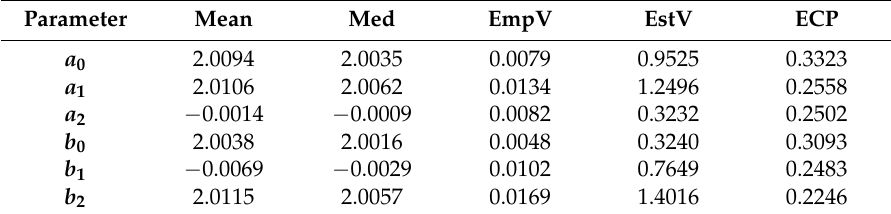
Table 1. Result from simulation studies (5000 Simulations).